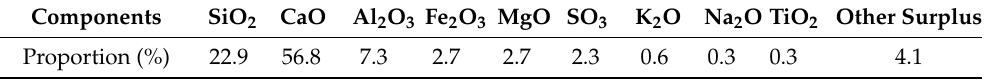
Table 2. Chemical components of cement